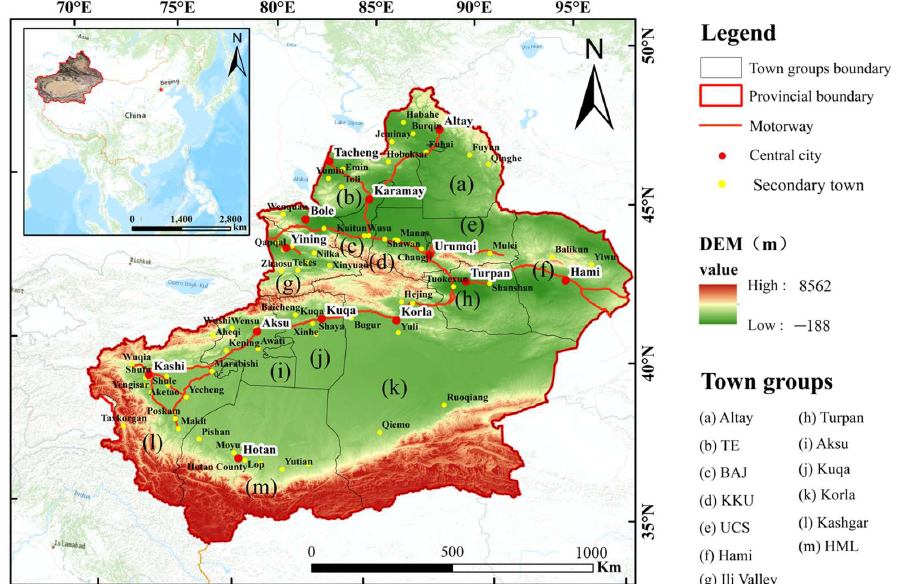
Figure 1. Landform map and locations of town groups in Xinjiang, China. Notes: (a) Altay: Altay